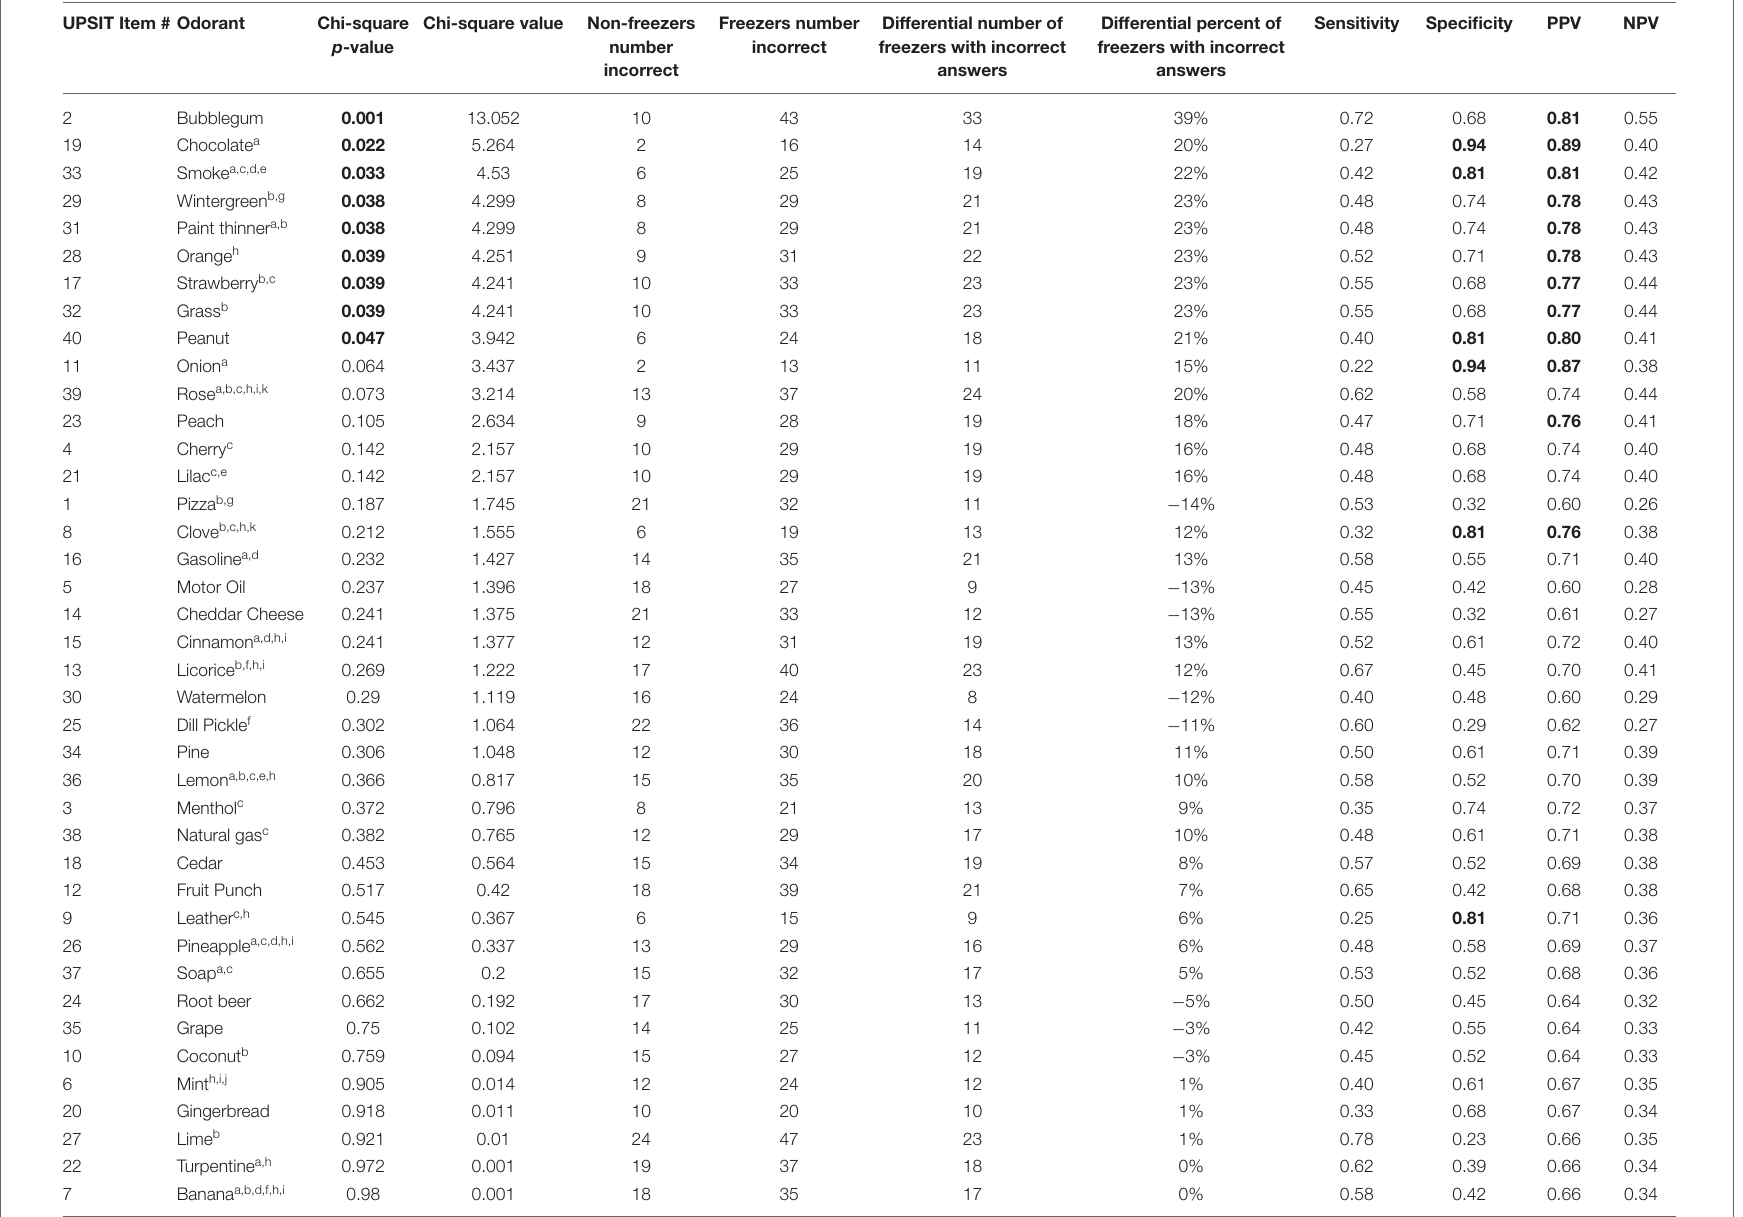
TABLE 2 | Individual odorant categorization statistics for freezers vs.